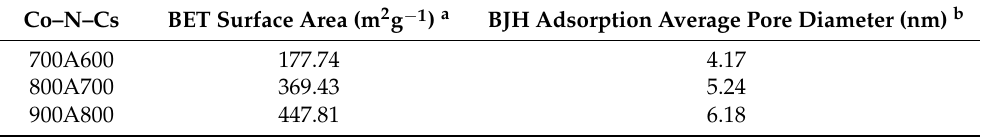
a : obtained from Figure 8a; b : obtained from Figure 8b.